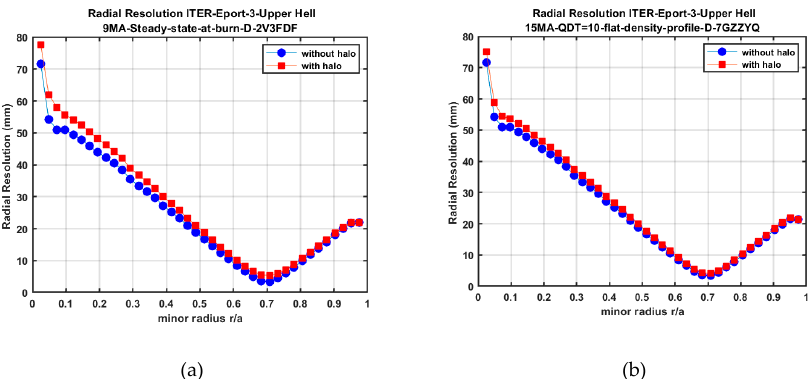
(b) Figure 11. ( a ) radial profile of halo fraction (I halo /(I prompt +I halo ), HeII 9MA-steady-state-at-burn scenario; (b) radial profile of halo fraction (I halo /(I prompt +I halo ), HeII 15MA-flat-density scenario. The observed halo spectrum is a line-of-sight-integrated spectrum. Each step along the line-of- sight path s is mapped onto the associated flux surface label ρ = r/a, and the synthetic sum-spectrum is created by summing up each spectrum, characterized by its local Doppler width λ d and Doppler shifted peak position λ z,0 and weighted by its local emissivity n halo *n z *Q CX [